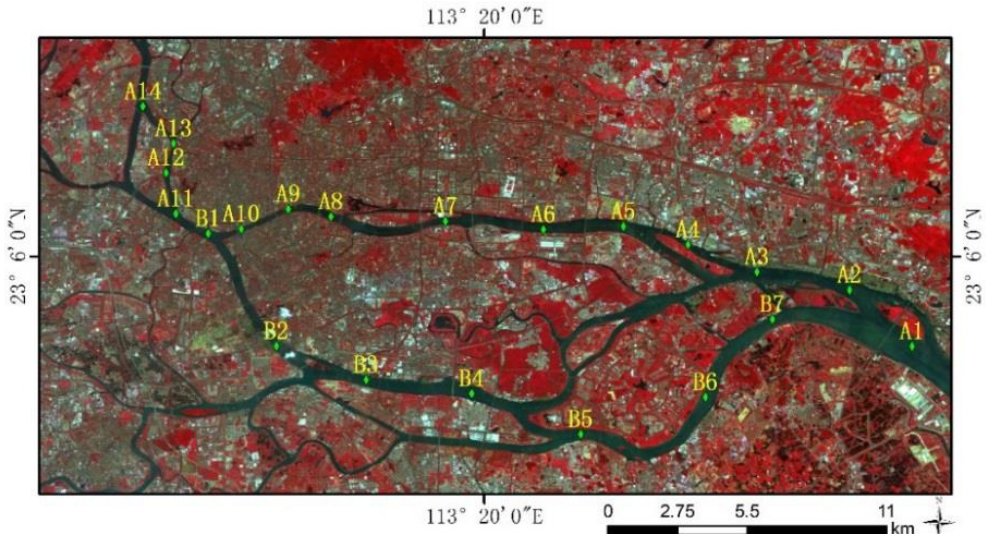
Figure 2. Distribution of the sampling sites during the simultaneous in situ observation experiment (5–6 August 2015).